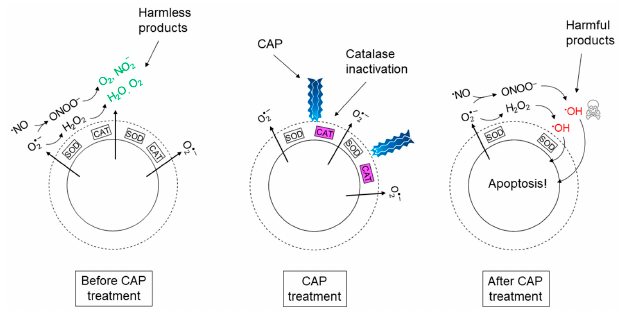
Figure 3. Proposed set of events underlying the mechanism of (selective) cancer treatment with cold atmospheric plasma (CAP). The cartoon picture represents a cancer cell and its extracellular compartment before, during, and after CAP treatment.